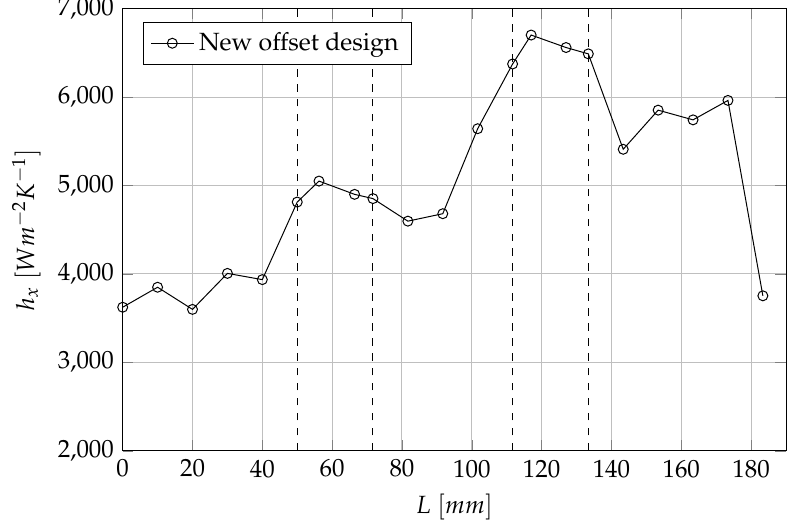
Figure 13. Local heat transfer coefficient ( h x ) enhancement of new offset design as a function of position within a serpentine passage at volumetric flow rate of 3.6 cm 3 s − 1 (start and end of each U-turn is shown by dashed